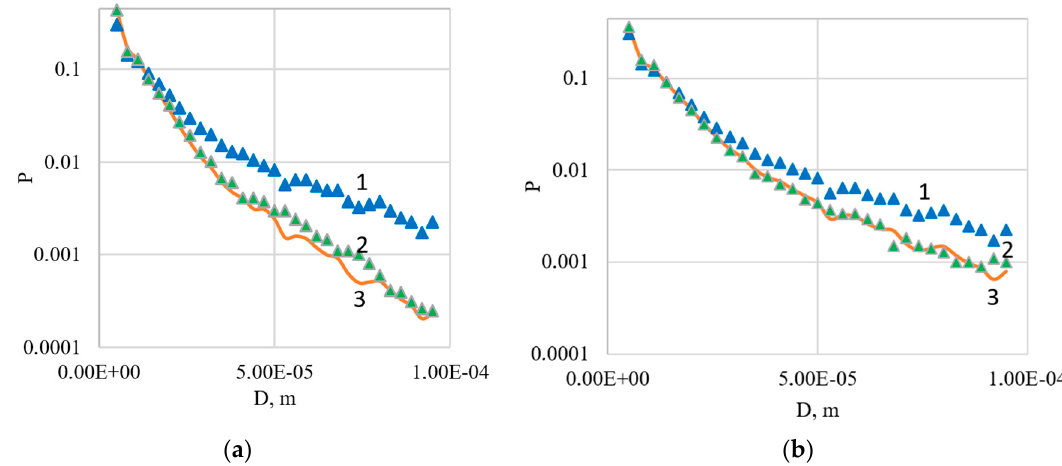
Figure 6. The example of fractional distribution without shock wave ( a ) and with shock wave ( b ): 1—experimental distribution in area 1; 2—experimental distribution in area 2; 3—calculated distribution in area 2.